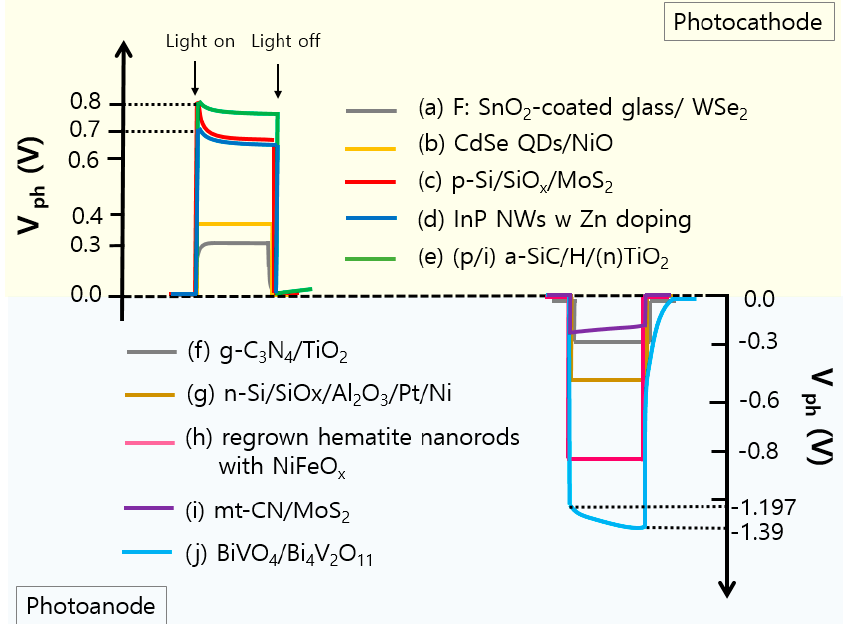
Figure 8. The comparison graphs of open-circuit potential (OCP) difference measurements redrawn based on the V ph value from the references [5,51–58]. Different type of photocathodes (positive transition) and photoanodes (negative transition) under dark equilibrium and under illumination are shown.